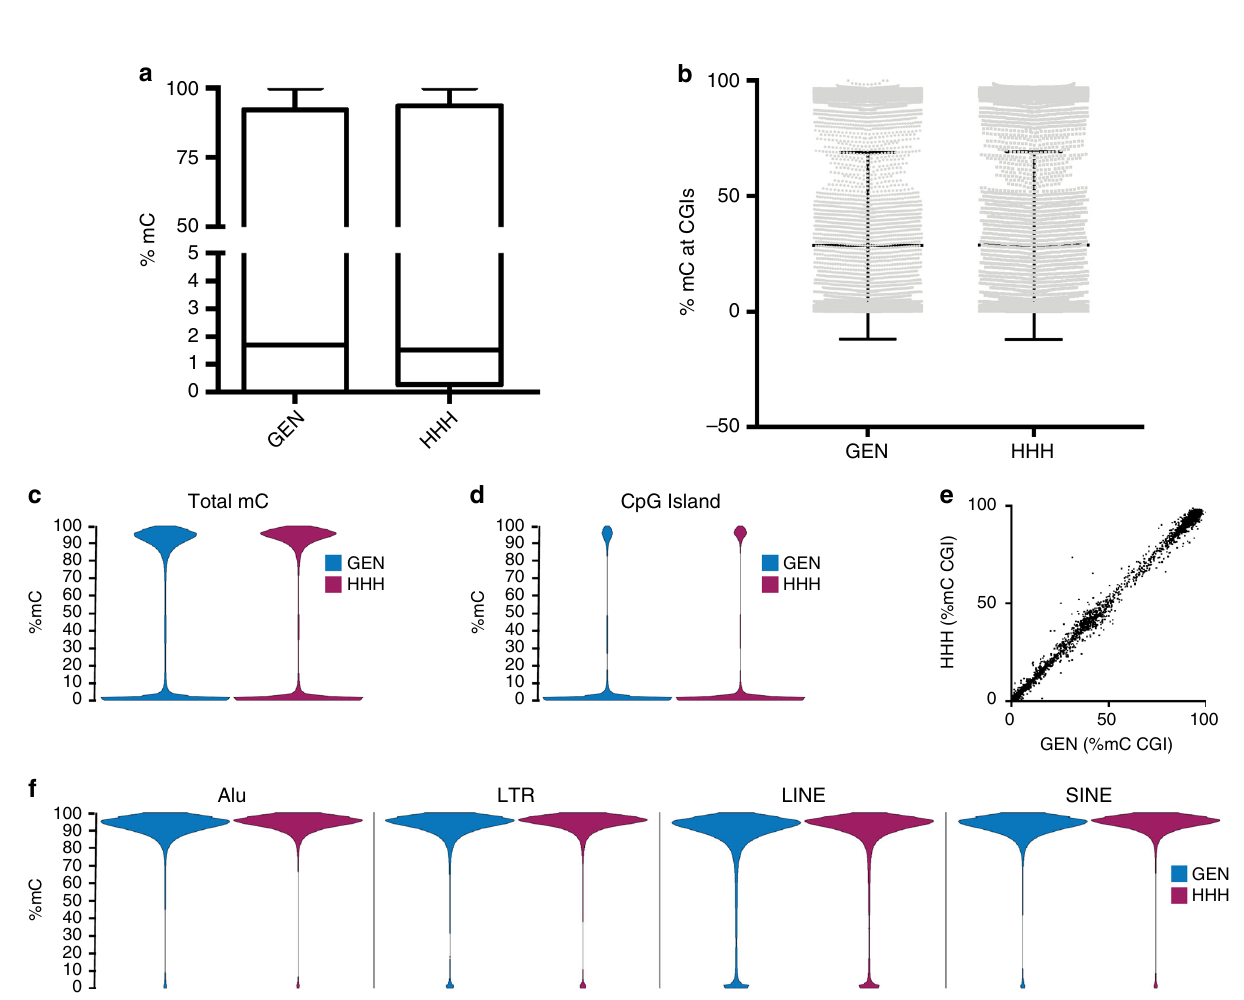
Fig. 6 Reduced representation bisul fi te sequencing analysis of DNA methylation in unsorted (GEN) and GCTM-2 high CD9 high EPCAM high (HHH) subpopulations. a , b Box plots of overall DNA methylation ( a ) and methylation at CpG islands ( b ). In a , line indicates median, box shows 25th to 75th percentile, and bars show maxima and minima. In b , line shows the mean and error bars show standard deviation. c , d Bean plots showing the distribution of DNA methylation (%mC) of individual CpGs, both genome wide ( c ) and at CpG islands ( d ). e Scatter plot showing the %mC at all CpG islands comparing the GEN and HHH populations. f Bean plots showing the %mC of individual CpGs at the repetitive elements of type Alu, LTR, LINE, and SINE. All data shown is the average for GEN ( n = 2) and HHH ( n = subsequent analysis. Although the initial survival of aggregates of the hPSC subpopulations was similar, further development of viable stem cell colonies was observed predominantly in the fraction bearing the highest level of stem cell markers. Time-lapse video microscopy revealed that cells in the GCTM-2 high CD9 high